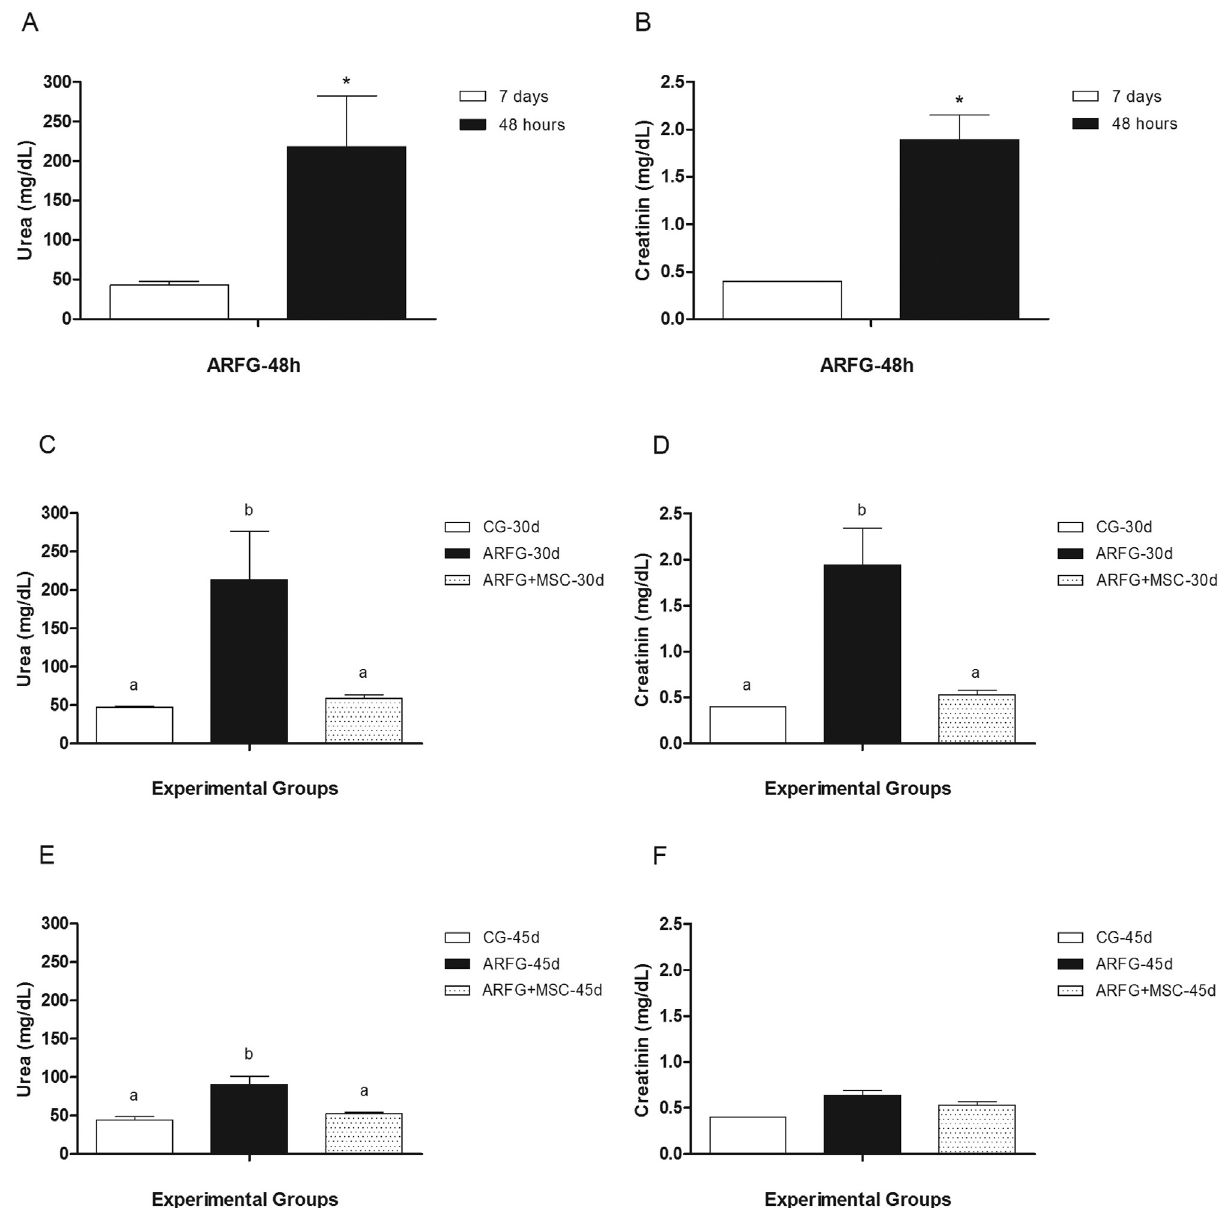
Figure3 -Ureaandcreatinineplasmaticconcentration(mean±SD).AandB)Confirmationofacuterenalfailure.ARFG-48h:Acuterenalfailuregroup; animals were treated with cisplatin, evaluated seven days before and 48 h after the administration of the chemotherapy. C and D) Animals were evaluated 30daysaftertheadministrationofthechemotherapy.EandF)Animalswereevaluated45daysaftertheadministrationofthechemotherapy.CG:Control group. ARFG: Acute renal failure group; animals treated with cisplatin. ARFG+MSC: In this group, MSC were transplanted to animals with acute renal failure 24 h after the chemotherapy administration. Statistical analysis: A and B: Mann-Whitney, *statistically significant differences, p (cid:3) 0,05; C to F: Kruskal-Wallis with Dunn’s post-hoc test; different letters indicate statistically significant differences, p (cid:3)